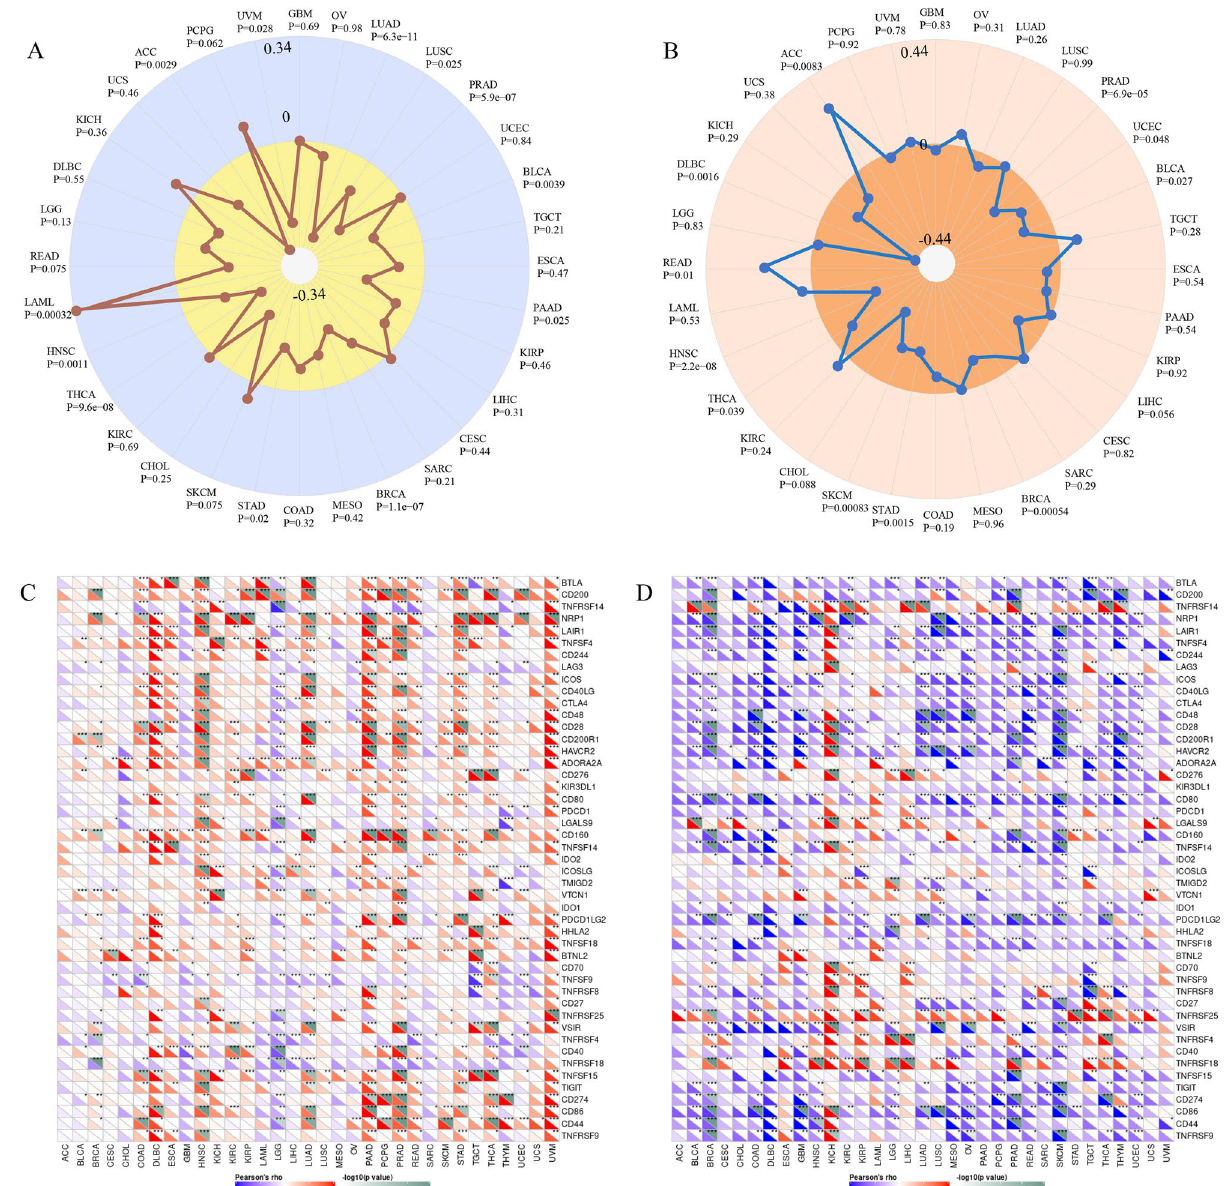
Figure 5. The relationship between gene expression and TMB, MSI, and ICP genes in pan-cancer. The relationship between PIK3R1 expression and TMB ( A ), MSI ( B ). Through the SangerBox tools, the Spearman rank correlation test was adopted, P < 0.05 was considered as statistically significant. The relationship between ICP genes and the expression of PIK3R1 ( C ), PIK3R2 ( D ). Analysis through the SangerBox 3.0 tools (http:// sange rbox. com/ Index). The lower triangle of each small square indicates the Pearson’s correlation coefficient and the upper triangle indicates the log-transformed p-value. *P < 0.05, **P < 0.01, ***P <